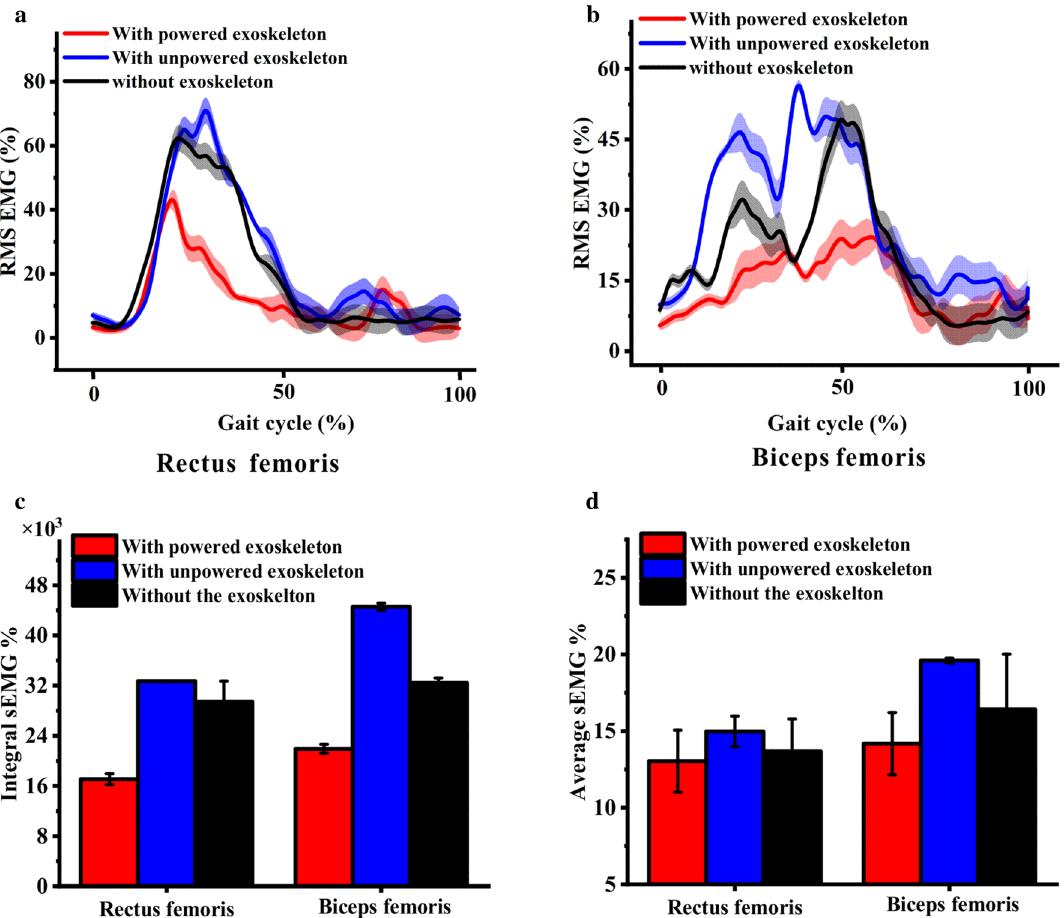
Figure 5. Surface EMG signals of BF and RF muscles during walking on a treadmill with a gait cycles. ( a ) RMS sEMG of RF with three conditions; ( b ) RMS sEMG of BF with three conditions; ( c ) IEMG of RF and BF muscles with three conditions; and ( d ) AEMG of RF and BF muscles with three conditions. The shaded area represent the standard